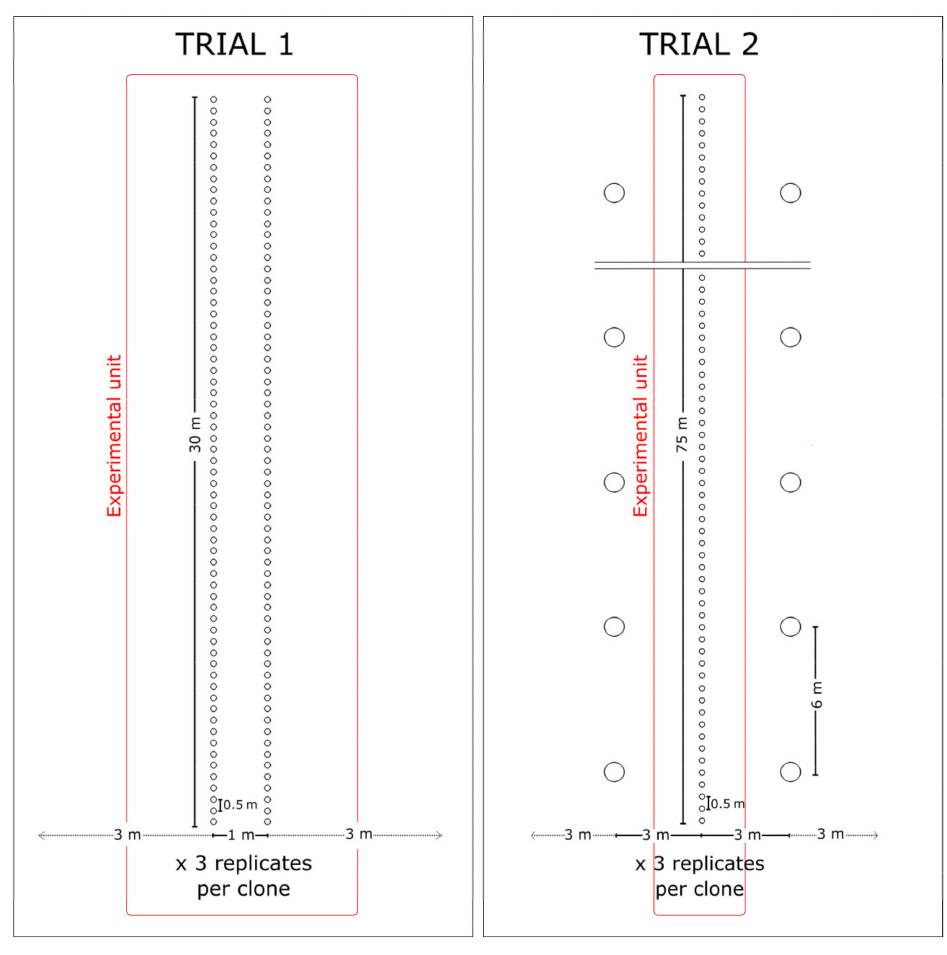
Figure 1. Layout of experimental units in trials 1 and 2. Each experimental unit had 3 replicates per